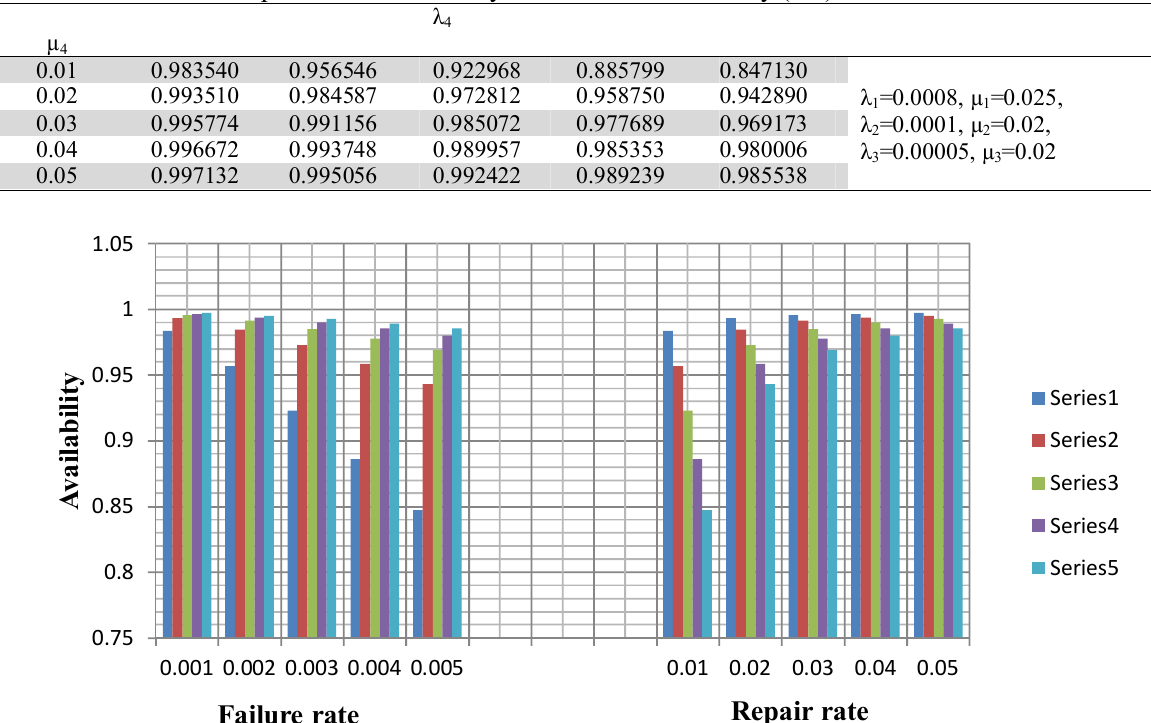
Effect of Failure and Repair Rates of Primary Air Fan on Availability (A